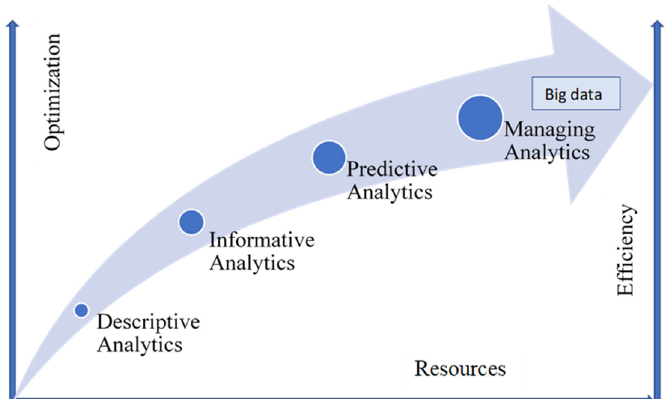
Figure 3. Development of data analytics elements of big data and the resulting benefits for data-driven decision making in wood procurement logistics.